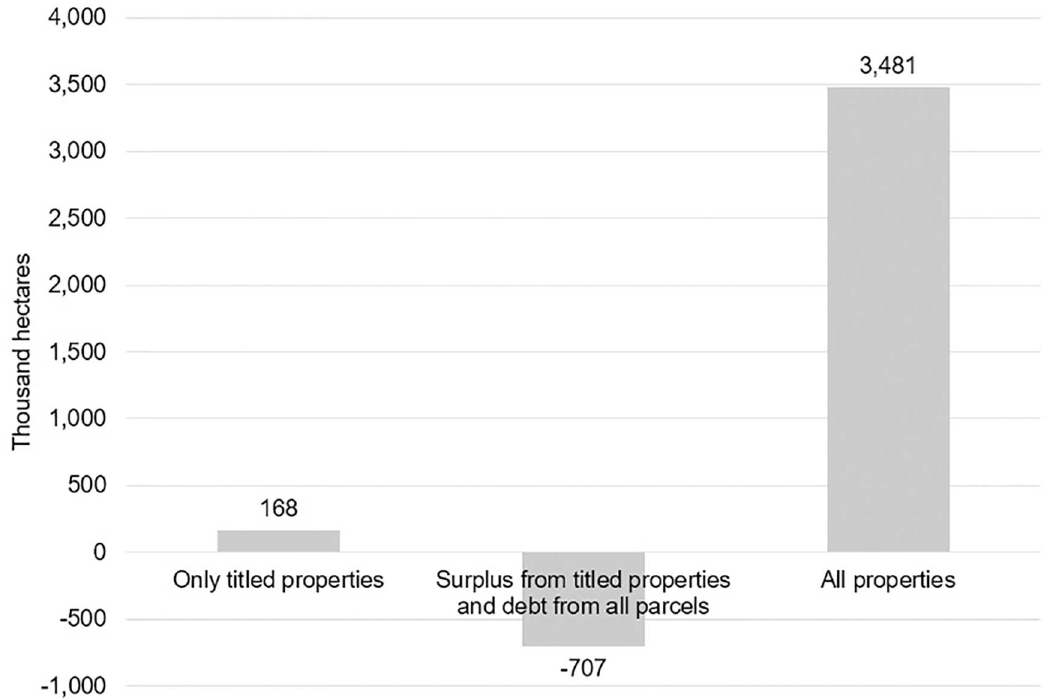
Fig 3. Sum of forest surplus minus sum of forest debt in three scenarios as of 2014.